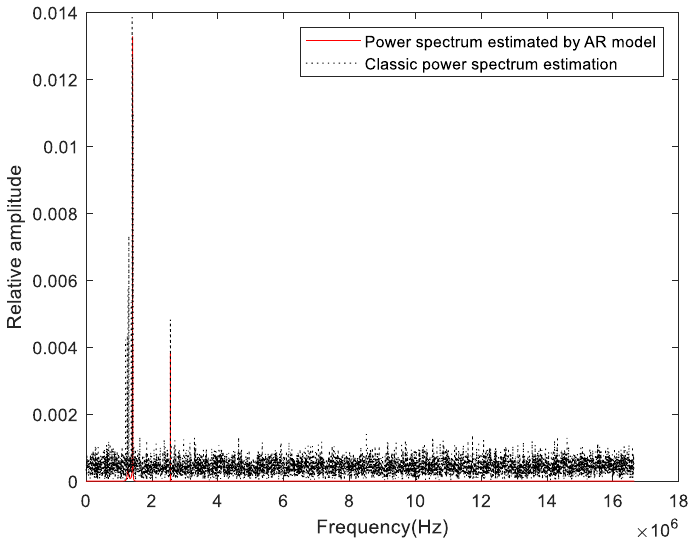
Figure 4. Two methods of power spectrum estimation for the HIFU echo signal.